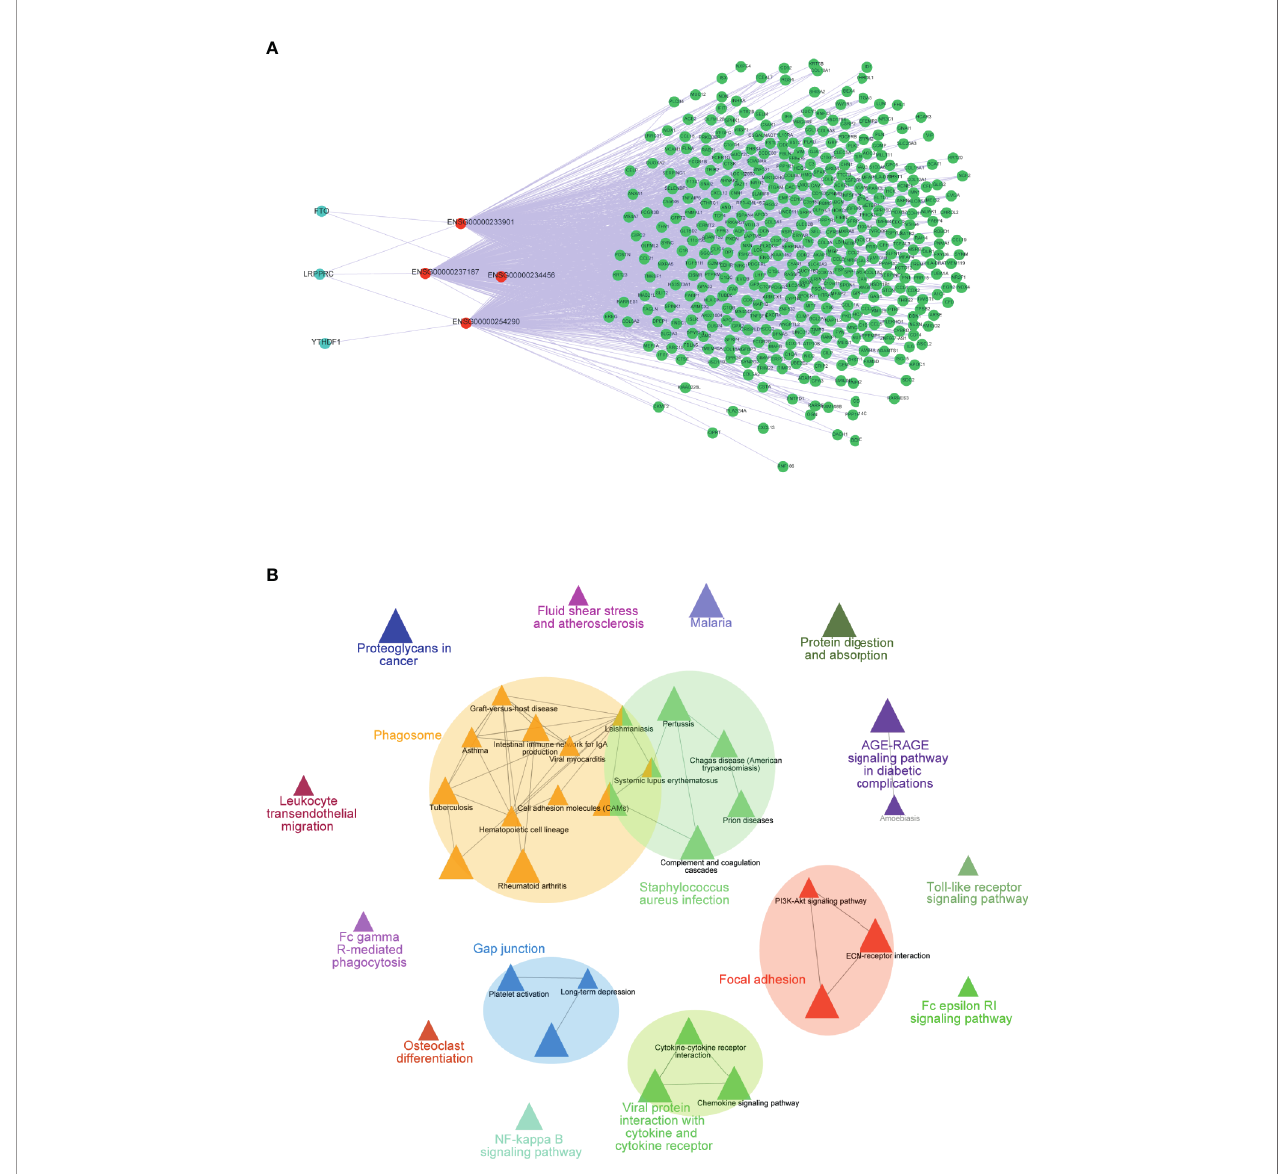
FIGURE 7 | Co-expression network of m6A-TME-LM. (A) The network was constructed based on m6A-TME-LM. Red nodes represent lncRNAs, blue nodes represent m6A regulators and green nodes represent mRNAs. (B) Enrichment analysis of the co-expression network by